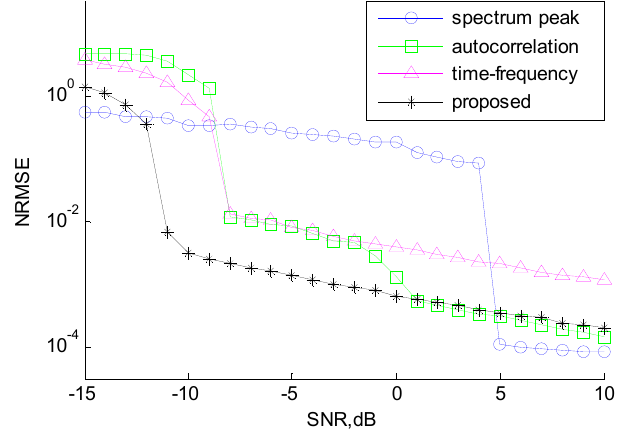
Figure 8. Normalized root mean square errors (NRMSE) of chirp rate estimation. Sensors 2018 , 18 , x FOR PEER REVIEW